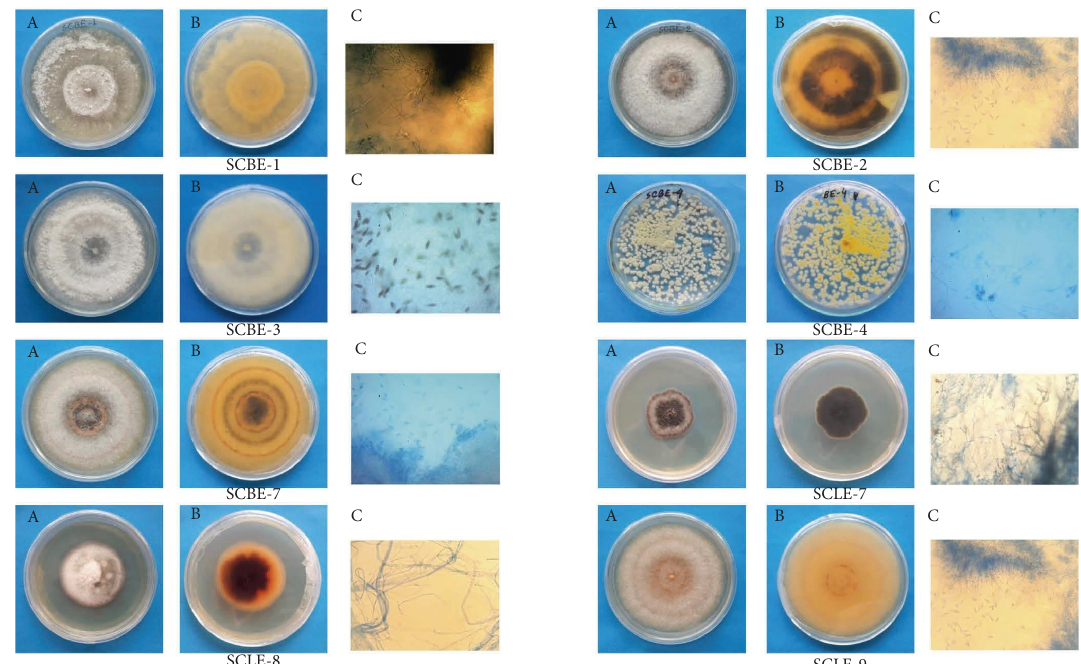
Figure 1: Morphological identifcation of isolated fungi. (a) Front view, (b) back view, and (c) microscopic